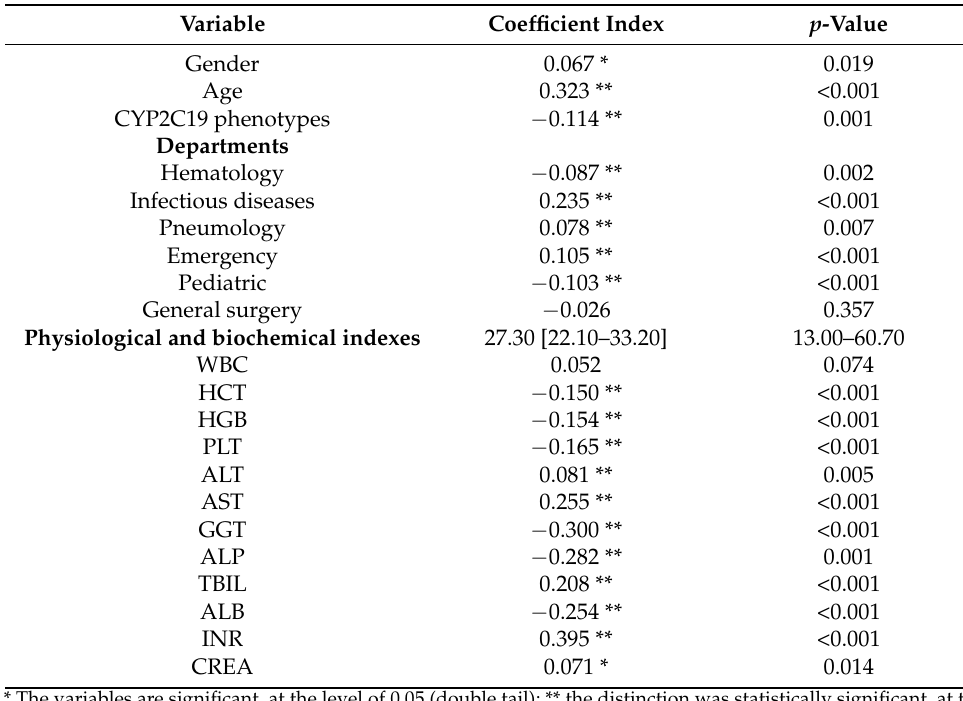
Table 3. Correlation analysis of voriconazole trough concentration.